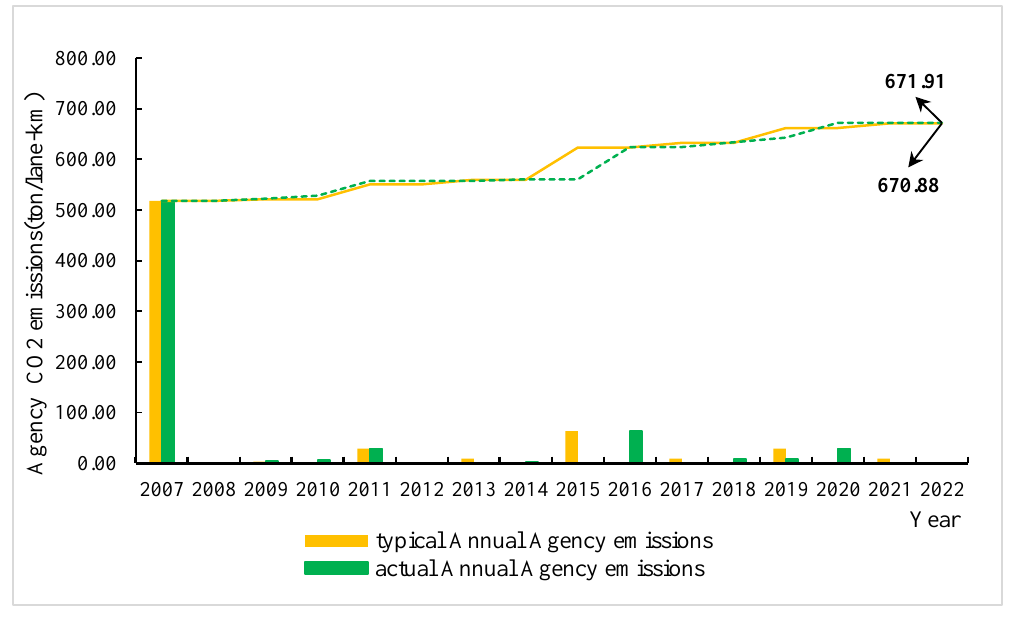
Figure 3. Life-cycle agency CO 2 emissions associated with the typical activity profiles and the actual activity profile.